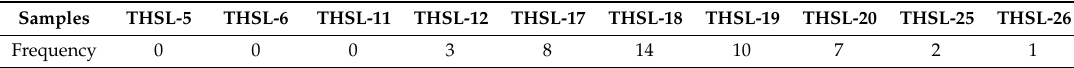
Table 1. The preference frequency results of the 10 traditional Hunan smoke-cured pork leg (THSL) samples with di ff erent smoke-curing